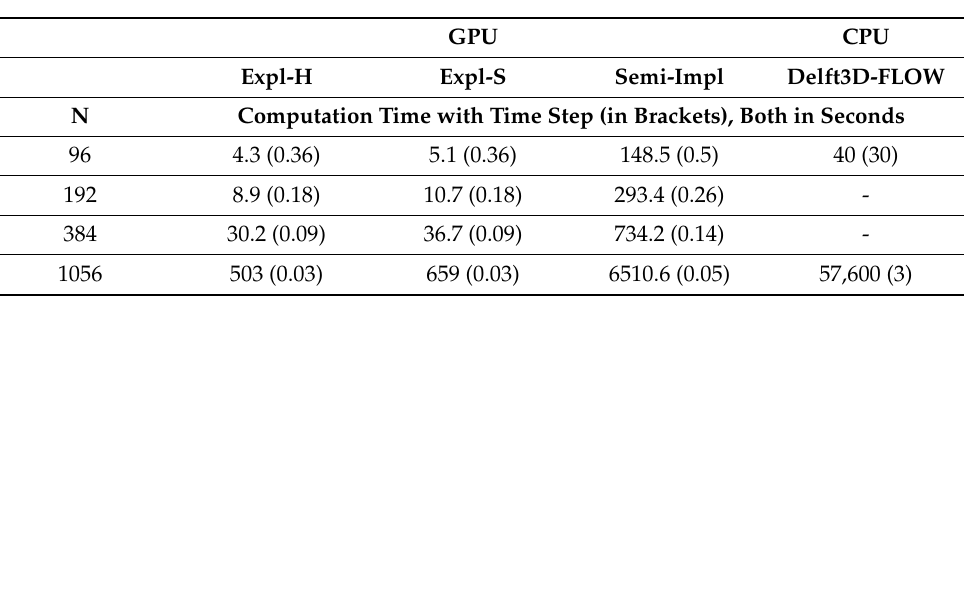
Figure 7. Two-dimensional flow velocity vector plot of test case 2 after 100 s on a 50 × 50 grid. Table 2. Computation times (in seconds) and average time step (in seconds) for a simulation period of one